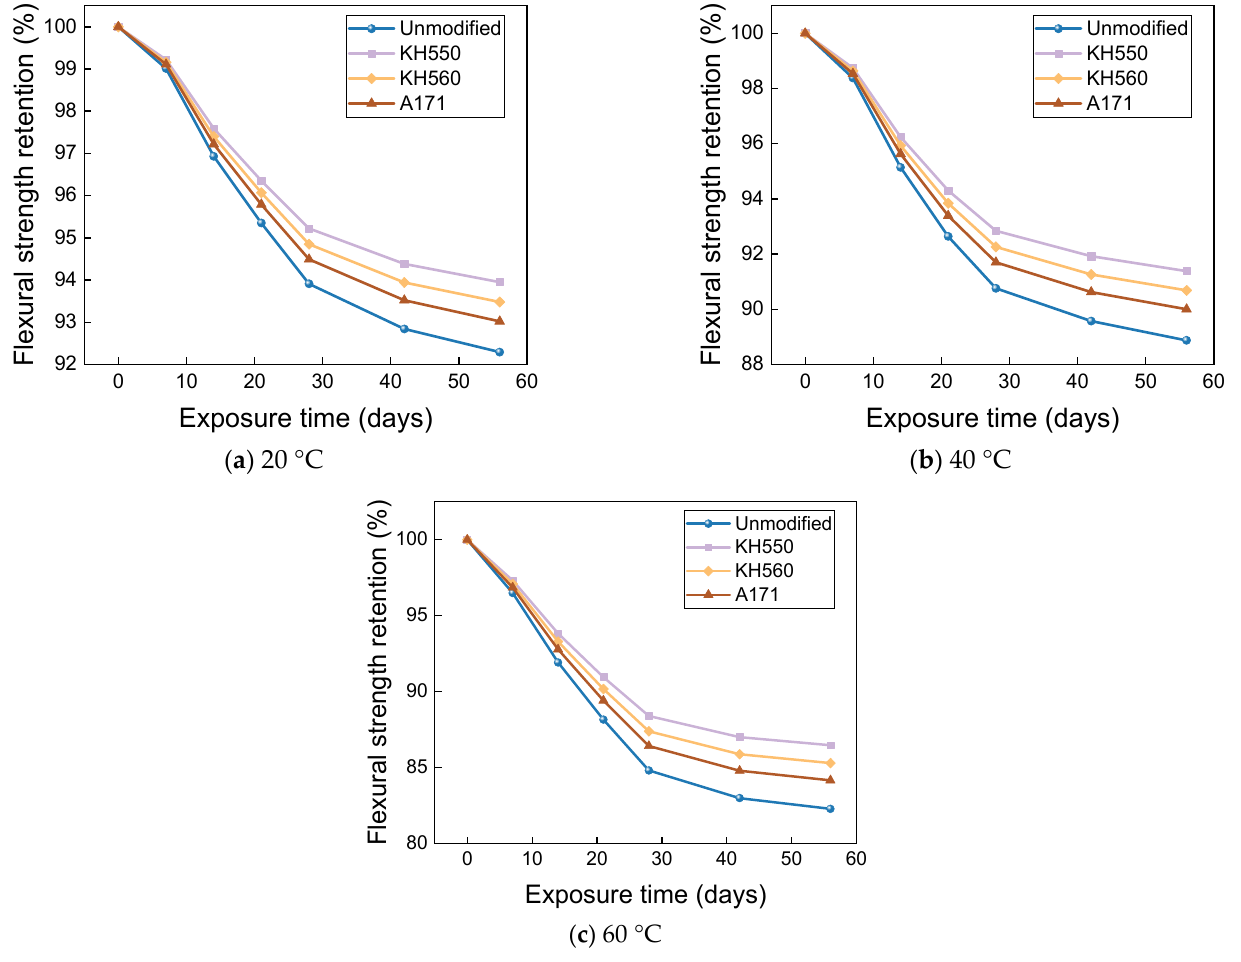
Figure 24. Flexural strength retention in a 10% NaCl high-concentration seawater environment.